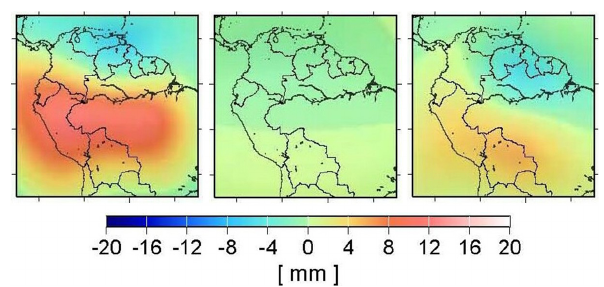
Figure 8. Geoid heights from 10-day solutions of GRACE obser- vations in May (wet season, left), September (dry season, middle), and December (right) 2003 (Schmidt et al.,